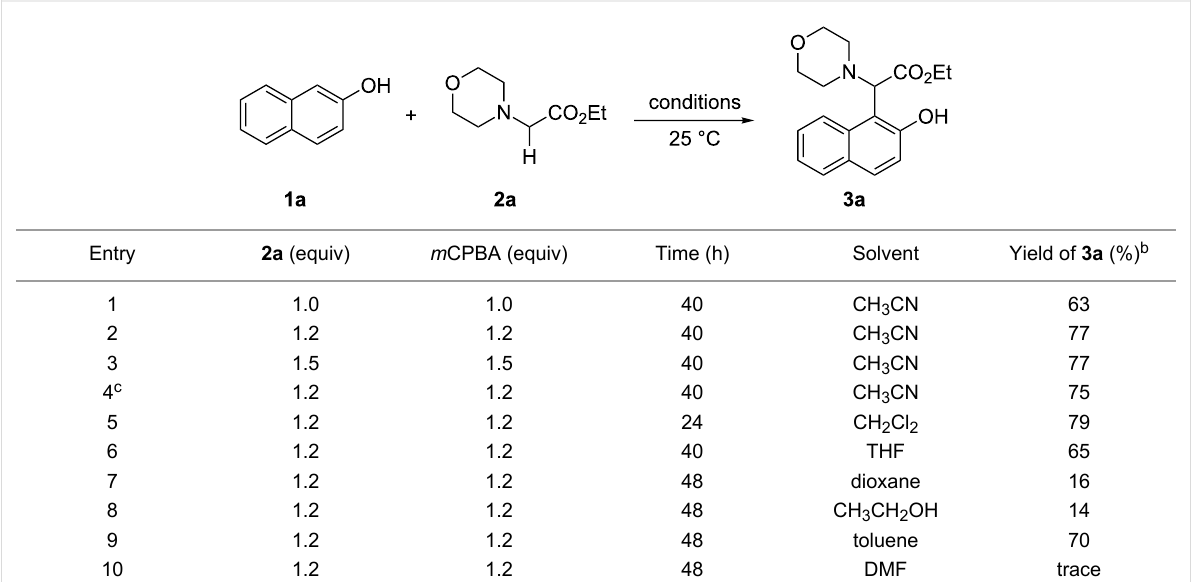
Table 2: Oxidative coupling reaction of naphthols and phenols with α -amino esters. a